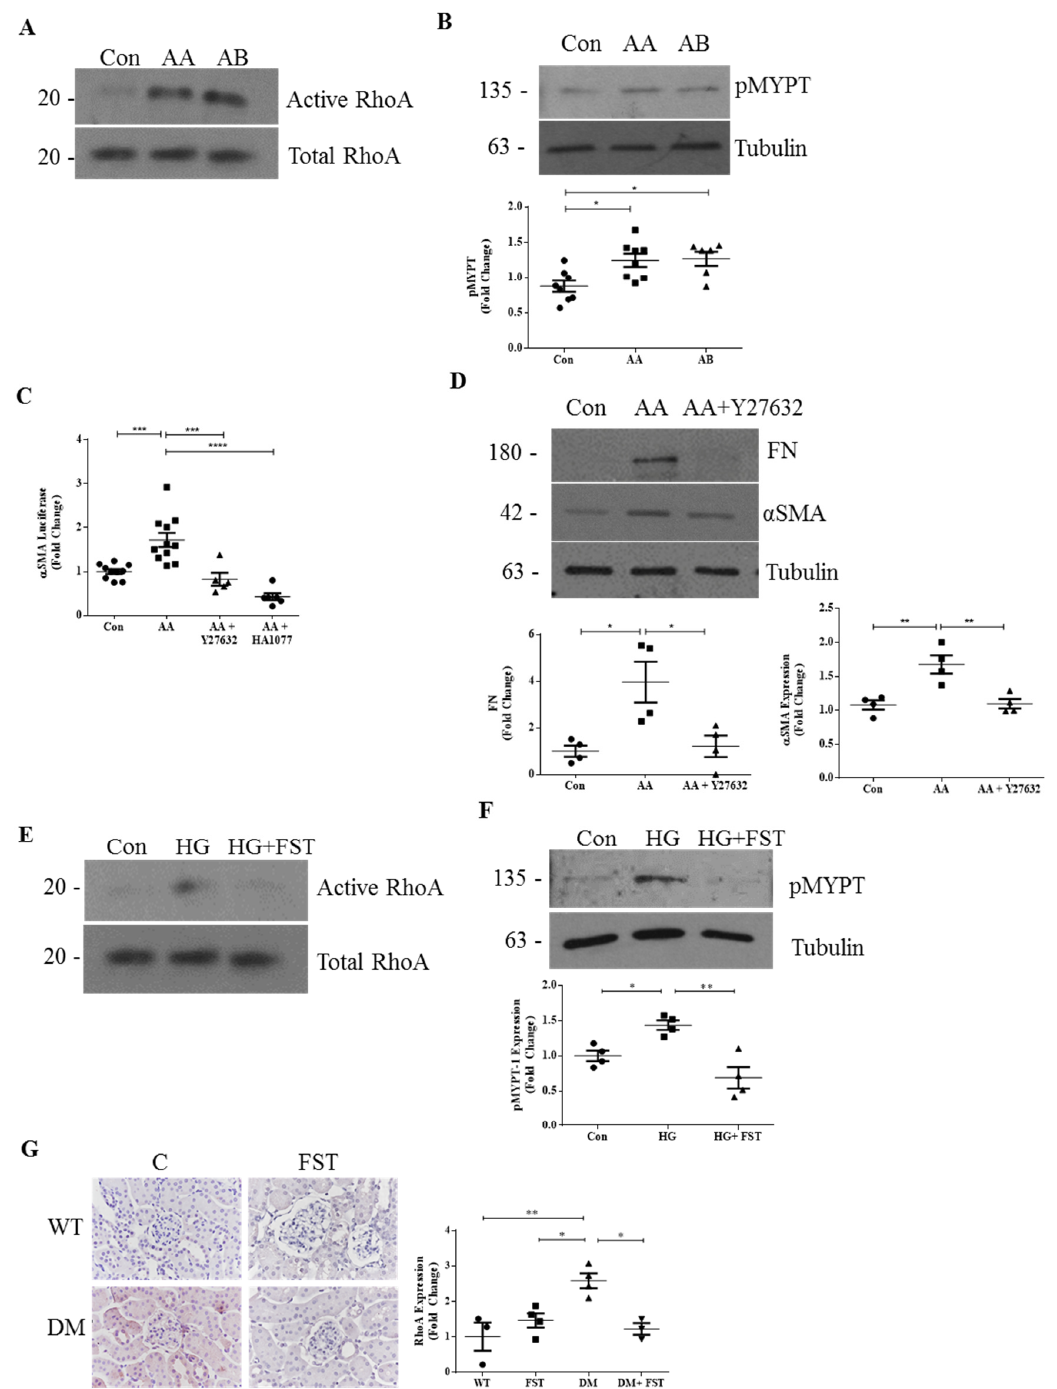
Figure 1. RhoA mediates the profibrotic effects of activins in diabetic kidney disease (DKD). ( A ) Activin A (20 ng/mL, 3 h) and activin B (20 ng/mL, 3 h) both activated RhoA in mesangial cells (MC) ( n = 2). ( B ) Activation of downstream Rho-kinase was also seen, assessed by phosphorylation of myosin phosphatase target (MYPT) (pMYPT Thr696) in MC ( n = 6–8 * p < 0.05). ( C ) Rho-kinase inhibition with Y27632 (10 μ M) or HA1077 (10 μ M) prevented activin A (20 ng/mL)-induced α -smooth muscle actin ( α SMA) promoter luciferase activation ( n = 6–11 *** p < 0.001, **** p < 0.0001) and ( D ) protein expression of both α SMA and the fibrotic protein fibronectin (FN) ( n = 4, * p < 0.05, ** p < 0.01). ( E ) The activin inhibitor follistatin (FST, 500 ng/mL) prevented high glucose (HG) (3 h)-induced RhoA activation ( n = 2) and ( F ) Rho-kinase activation ( n = 3, * p < 0.05, ** p < 0.01). ( G ) RhoA activation in kidneys was also significantly inhibited by follistatin in type 1 diabetic Akita mice, as assessed by IHC with an antibody which specifically detects active RhoA ( n = 4, * p < 0.05, ** p < 0.01).